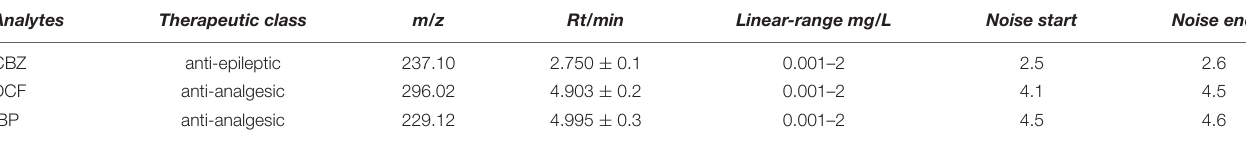
TABLE 1 | UPLC/MS method development parameters of selected pharmaceuticals.